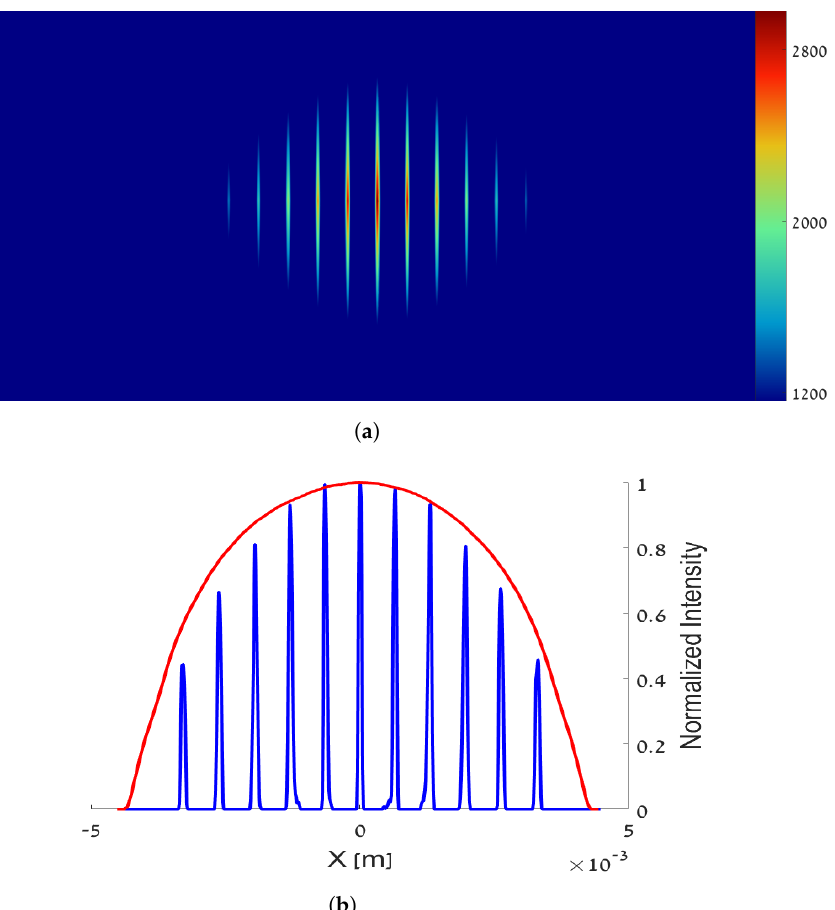
Figure 5. ( a ) Contour plot of the beamlets after passing the Tungsten slit-mask. ( b ) Beam profile before passing the Tungsten slit-mask in red and the beamlets after analysis in